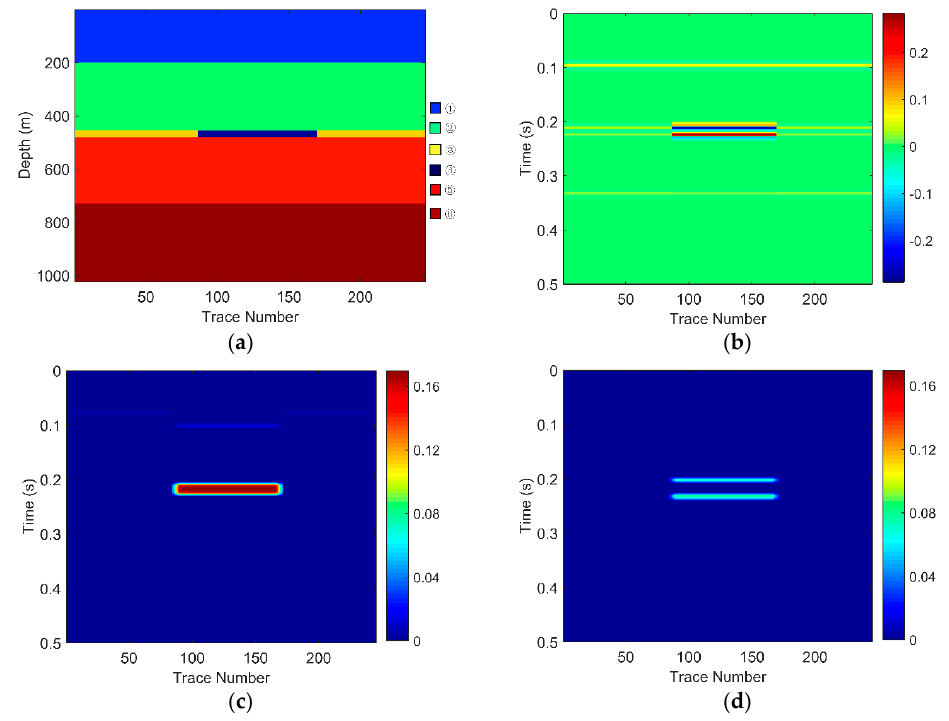
Figure 5. For Geological Model 3: ( a ) the gas-bearing layer is 25 m; ( b ) the seismic response; ( c ) the low frequency section; and ( d ) the high frequency section.